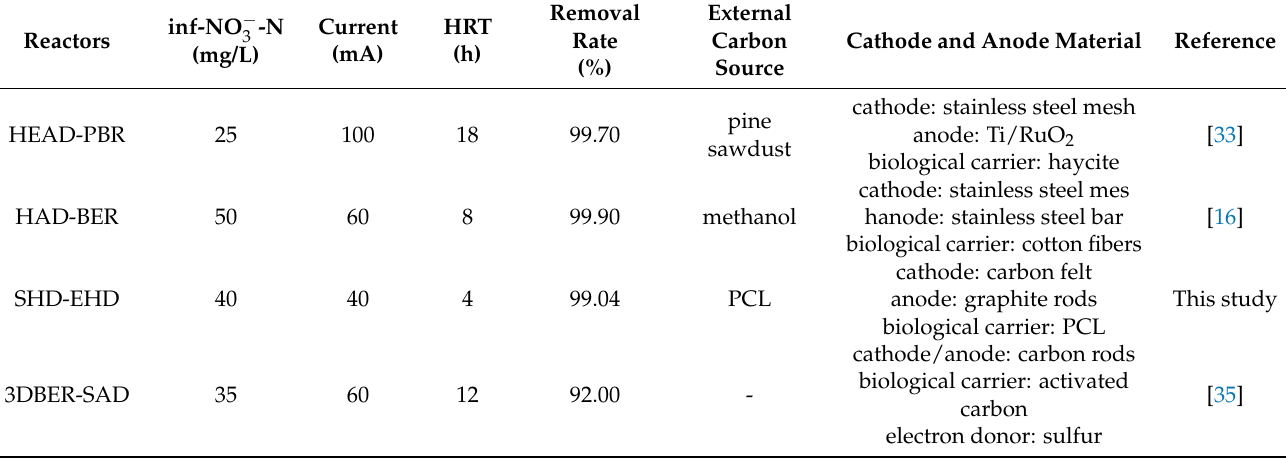
Table 2. Comparison with other denitrification